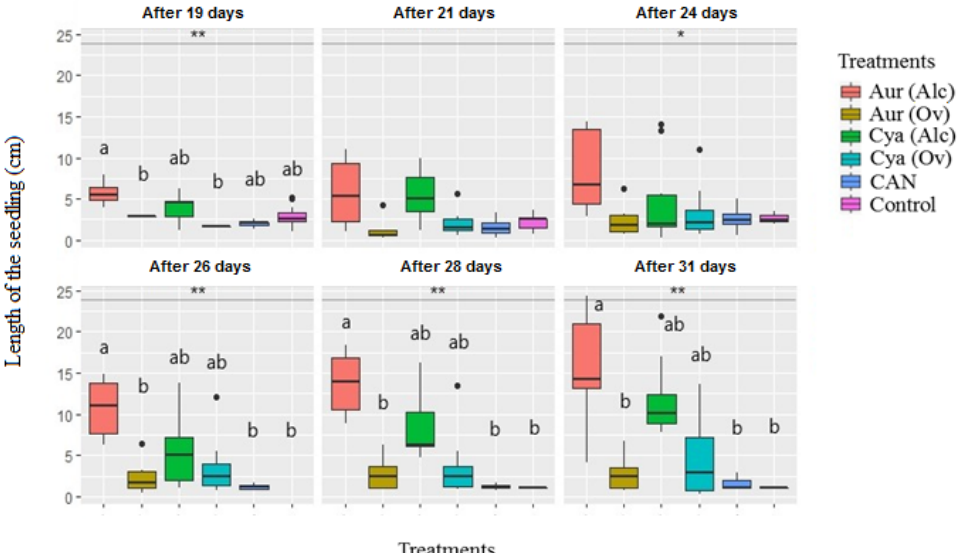
Figure 5. Average length of seedling (cm) under different treatments. Treatments followed by different letters according to Welch test significantly different at p < 0.05 and ANOVA test shows significantly different at * p < 0.05 and ** p < 0.01.